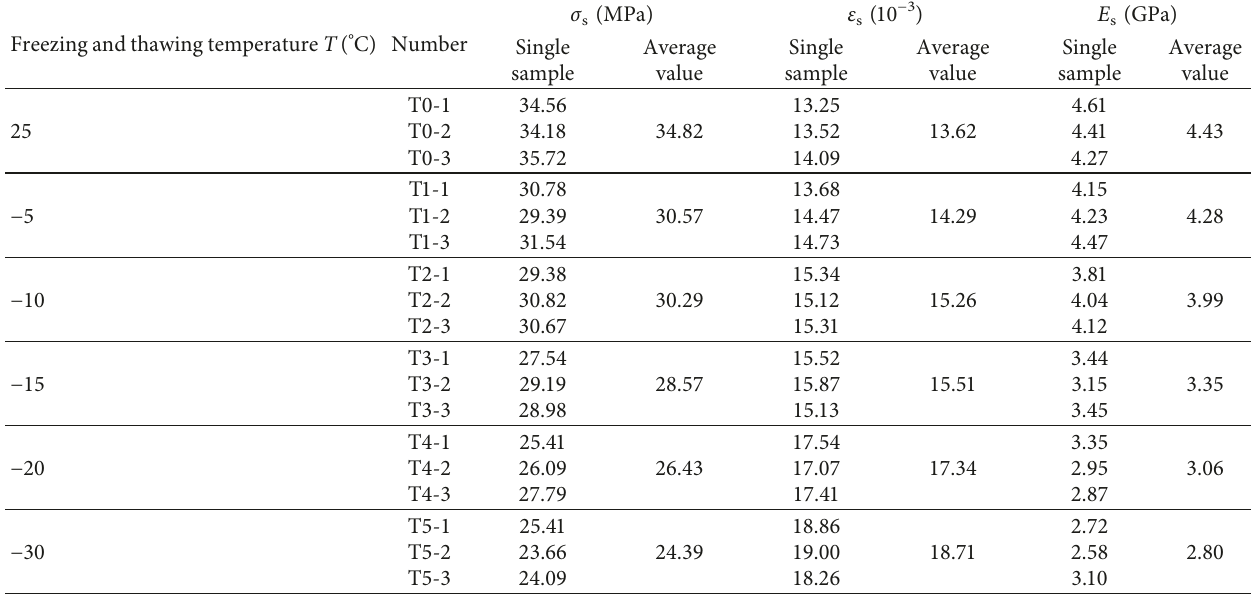
Table 1: Physicomechanical parameters of sandstone under different freeze-thaw temperatures.